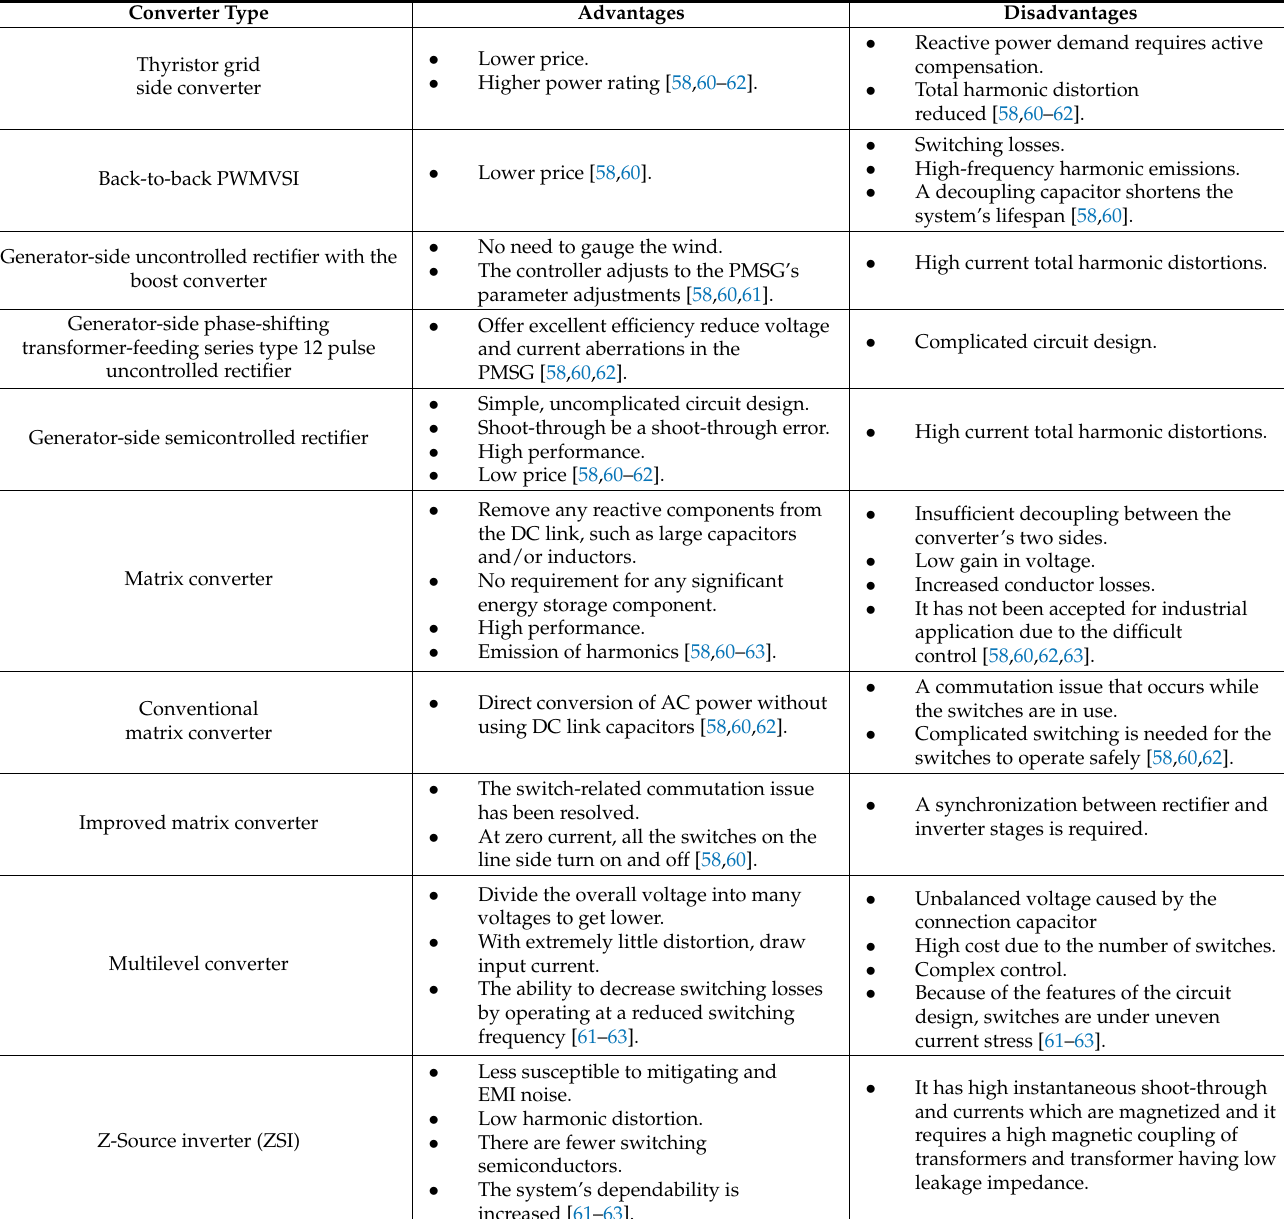
Table 5. Comparison of types of Power Converters